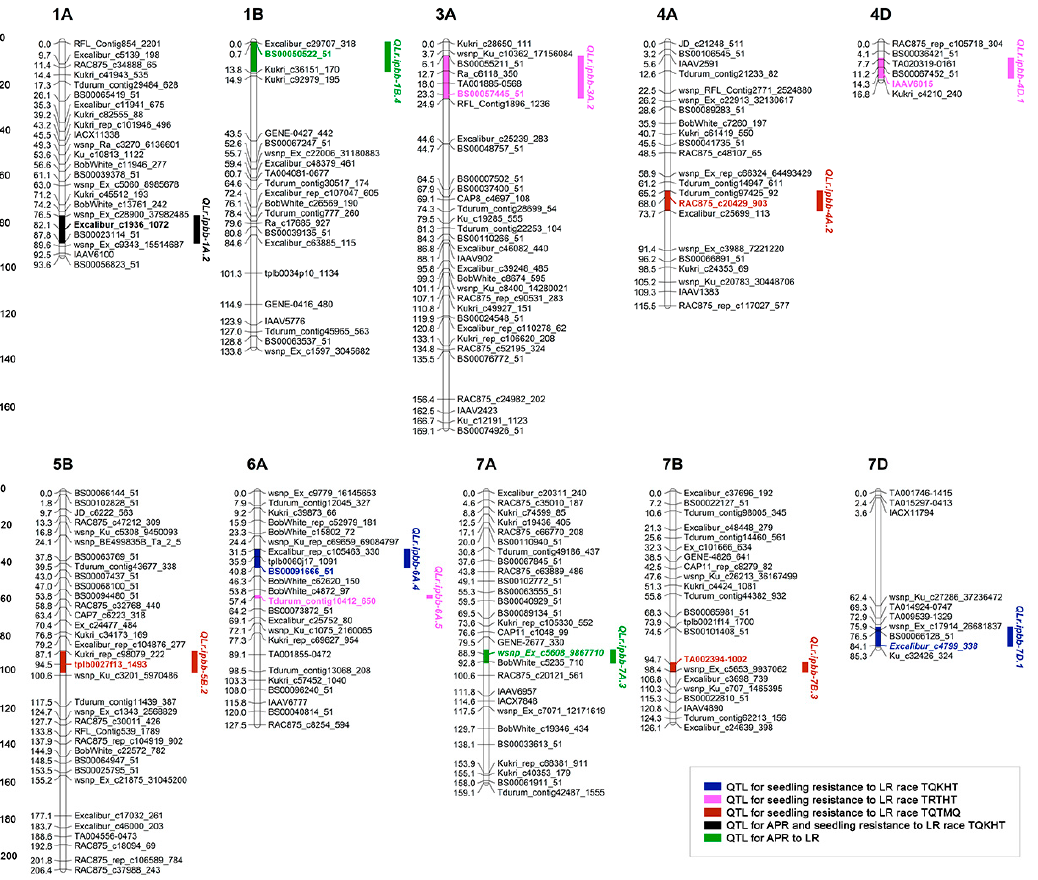
Figure 1. Pamyati Azieva × Paragon genetic map with quantitative trait loci (QTLs) for adult plant resistance (APR) to leaf rust (LR) in two regions and seedling resistance to three LR races. The region containing the QTL is indicated by a vertical bar on the right and followed by the name of the QTL. Single nucleotide polymorphism (SNP) markers are shown on the right and their genetic positions (cM) on the left. The peak marker for each QTL is highlighted in color and bolded. Colors of QTL indicate APR or race-specific seedling resistance.